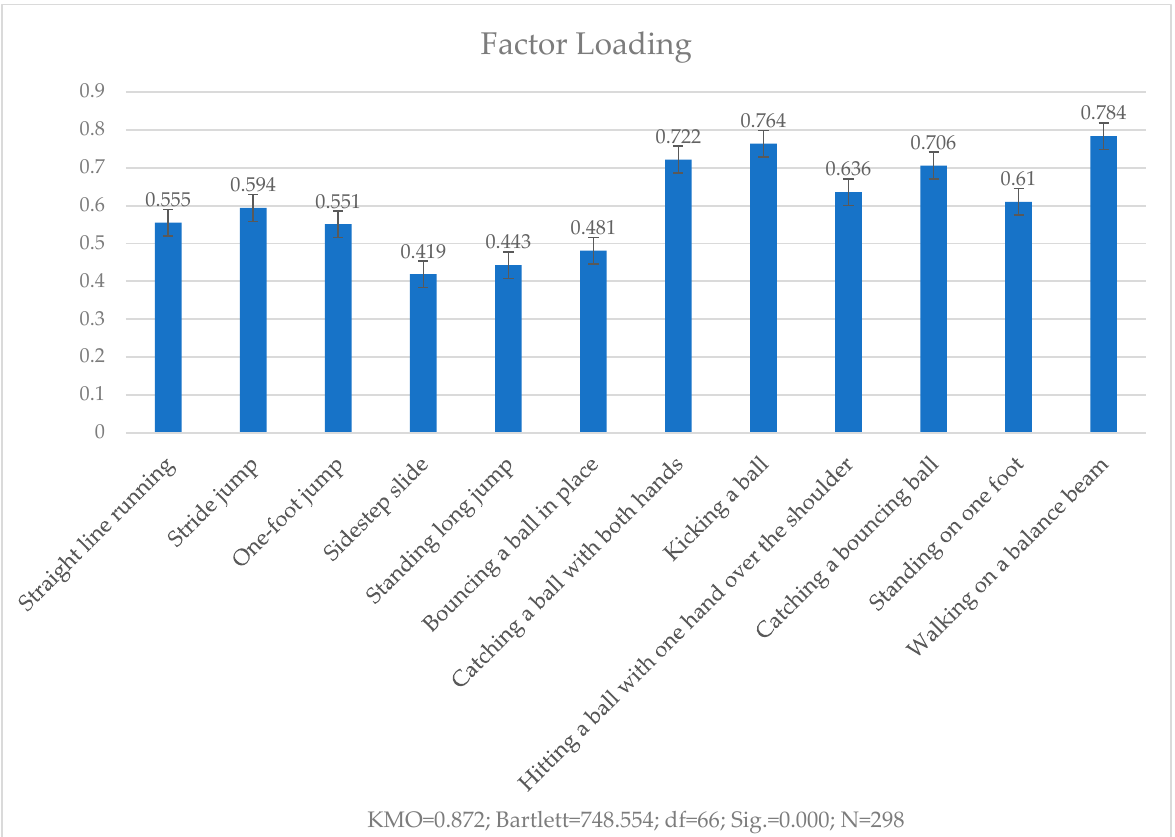
Figure 3. Factor loading of each item in the final measurement scale.